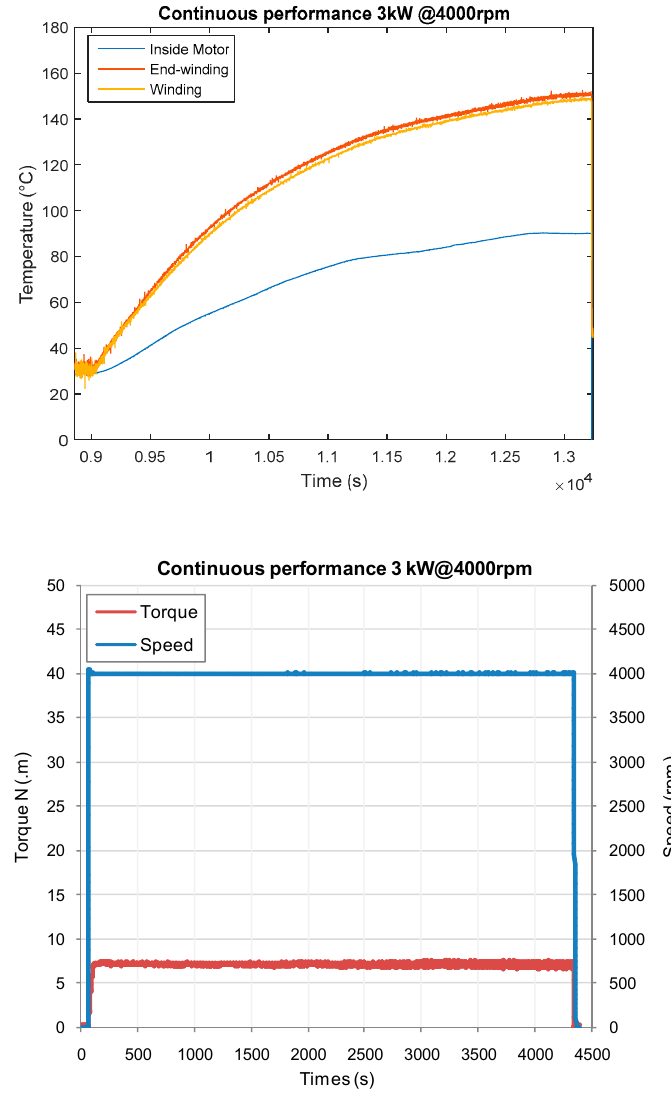
Figure 15. Rising temperatures at the operating point of continuous performance 3 kW at 4000 rpm during 71 mn.